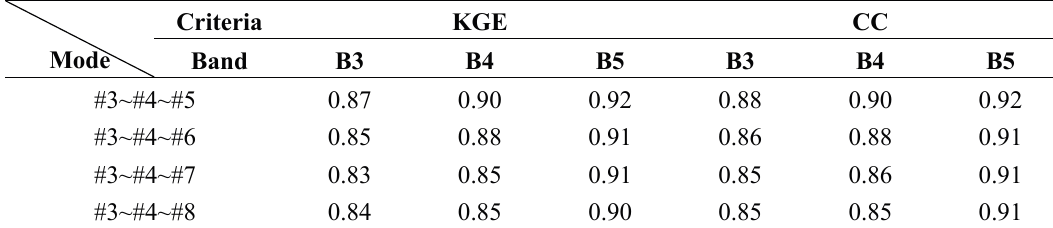
Table 5. The quantitative assessment of ESTARFM prediction performance using different prior input L-M pairs at the CIA site. For example, “#3~#4~#5” denotes the prediction